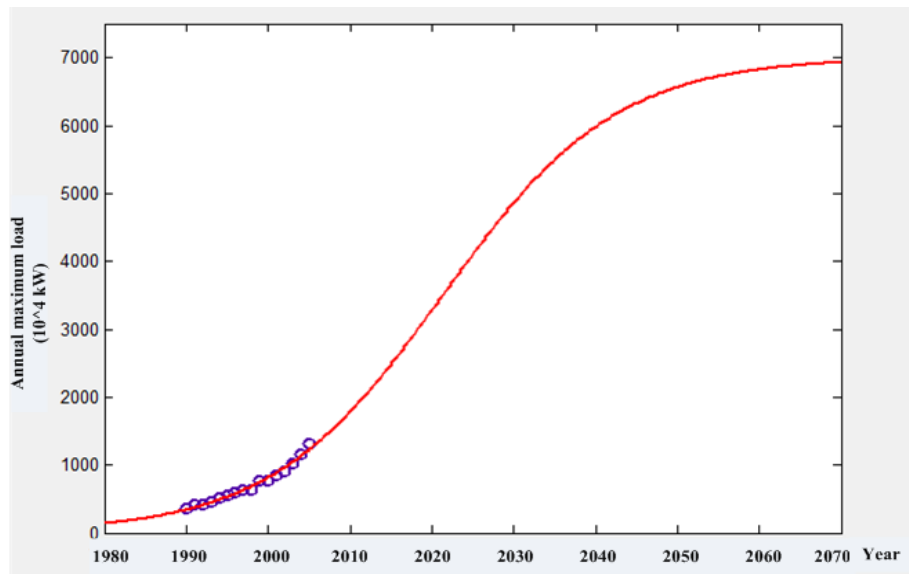
Figure 4. Fitting result of the logistic curve model in terms of annual maximum power load.